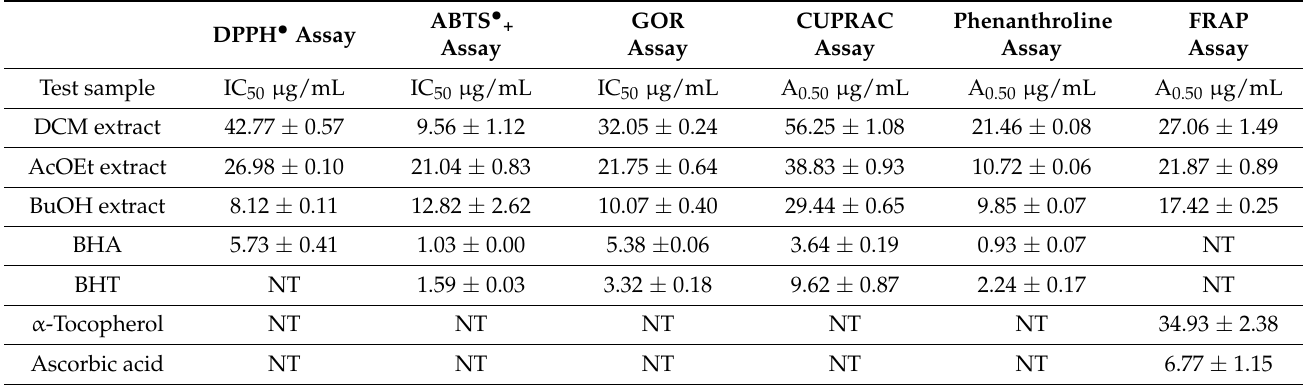
Table 5. Antioxidant activity of C. nepeta